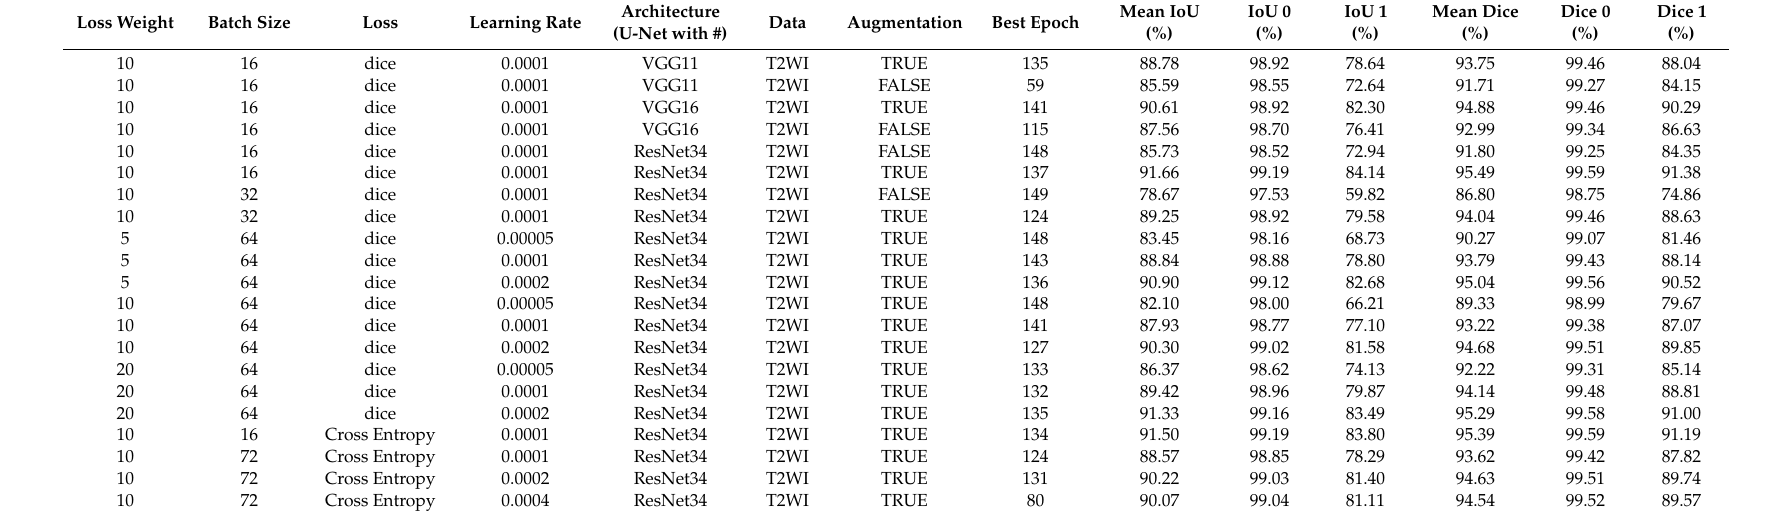
Table A6. Parameters and performance of all three architectures on “T2w” of the “uterus.”